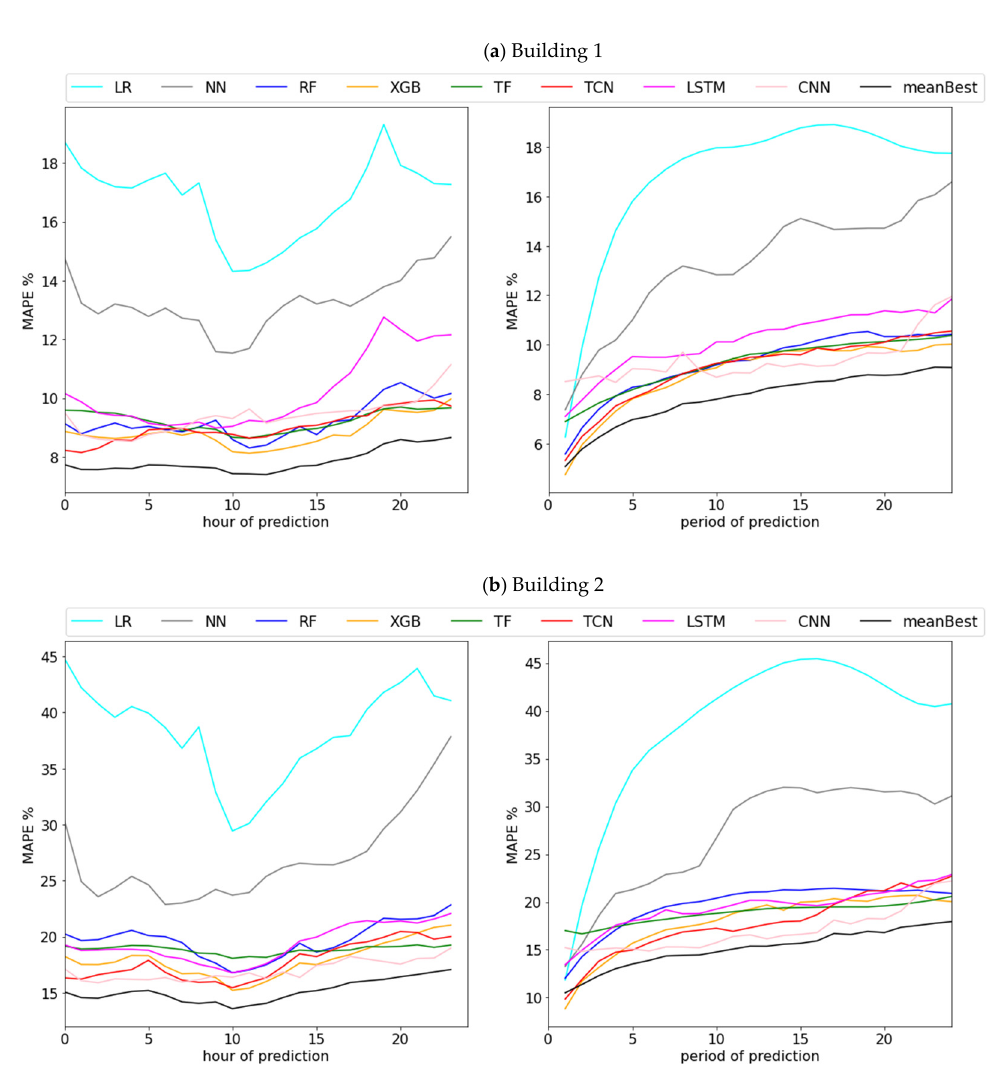
Figure 7. ( a ) Performance of forecasting models by the hour, and prediction period in building 1; ( b ) performance of forecasting models by the hour, and prediction period in building 2.